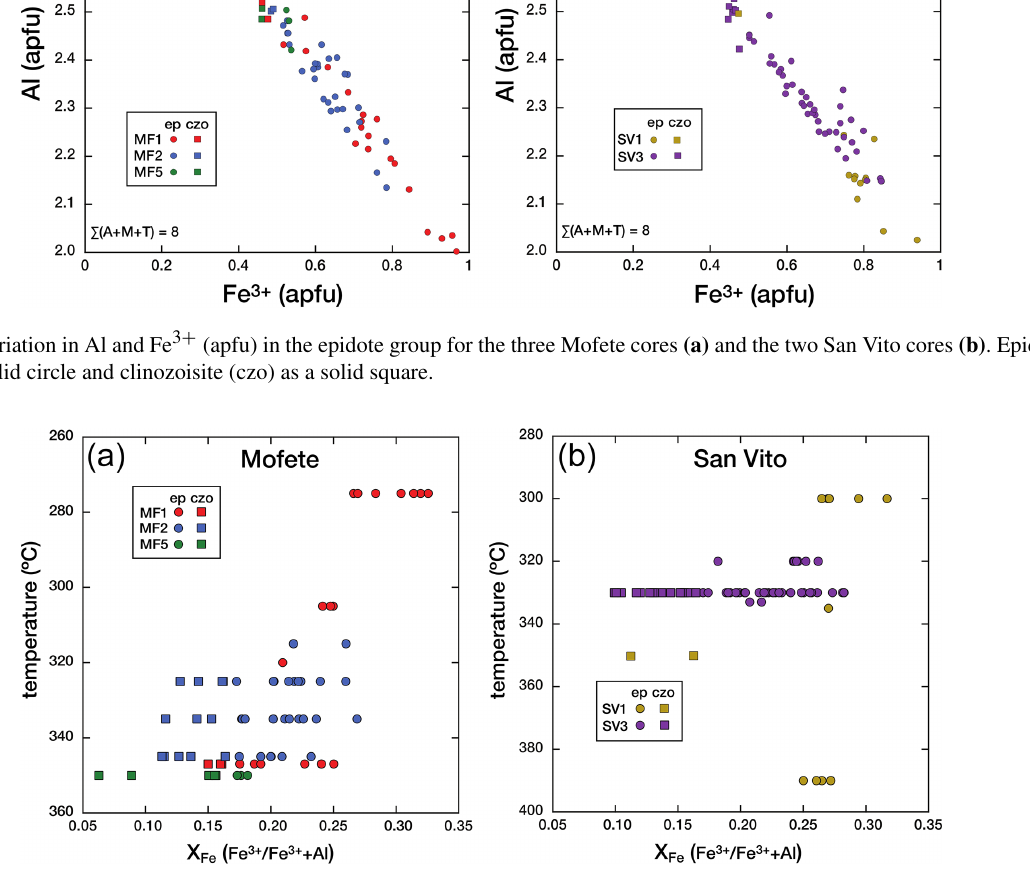
Figure 6. The variation in X Fe [(Fe 3 + ) / (Fe 3 + + Al)]apfu in the epidote group with measured well-hole temperature ( ◦ C) after stabilization (De Vivo et al., 1989) for Mofete (a) and San Vito (b) wells. Symbols are as in Fig. 5a and